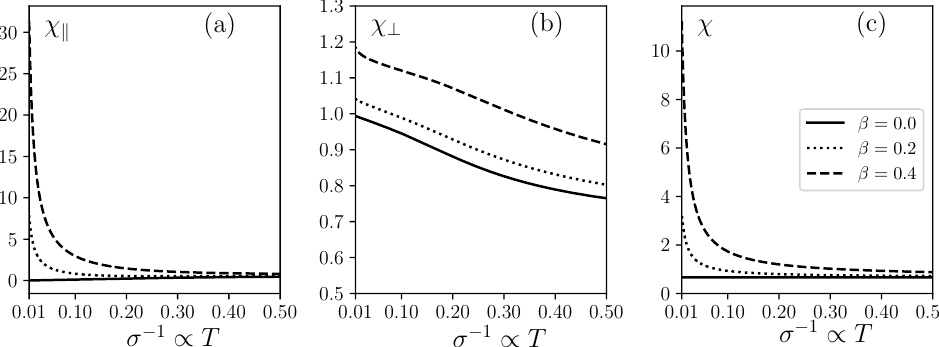
Figure 1. Temperature dependence of the static magnetic susceptibilities of an ensemble of AFM particles whose anisotropy axes are: ( a ) parallel with the applied field, ( b ) perpendicular to it, and ( c ) distributed at random; the decompensation parameter β = 0 (solid lines), 0.2 (dots), 0.4 (dashes). Note the different vertical scales in all three